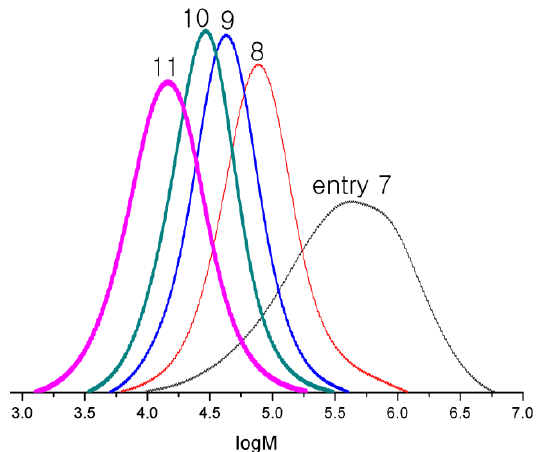
Figure 4. GPC curves for the polymers obtained in CCTP.